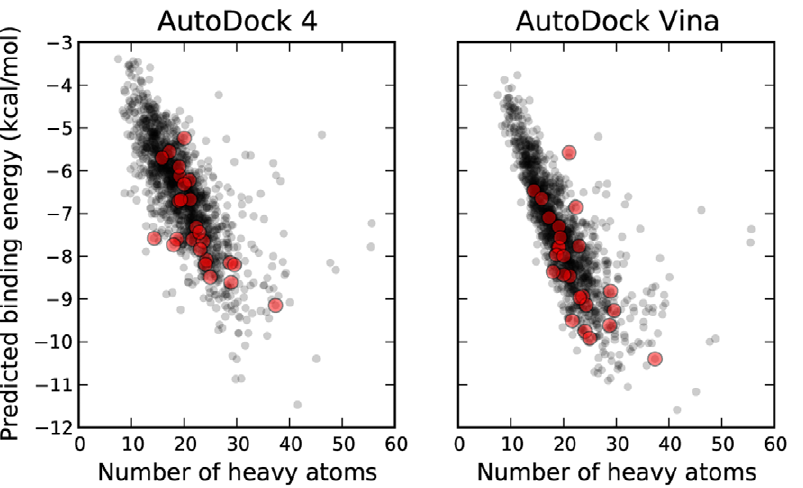
Figure 5. Predicted binding energies for NCI Diversity Set II compounds with HIV protease as a function of the number of heavy atoms in the compound. r = 2 0.75 and r = 2 0.79 for AD4 and Vina, respectively. Active compounds are highlighted in